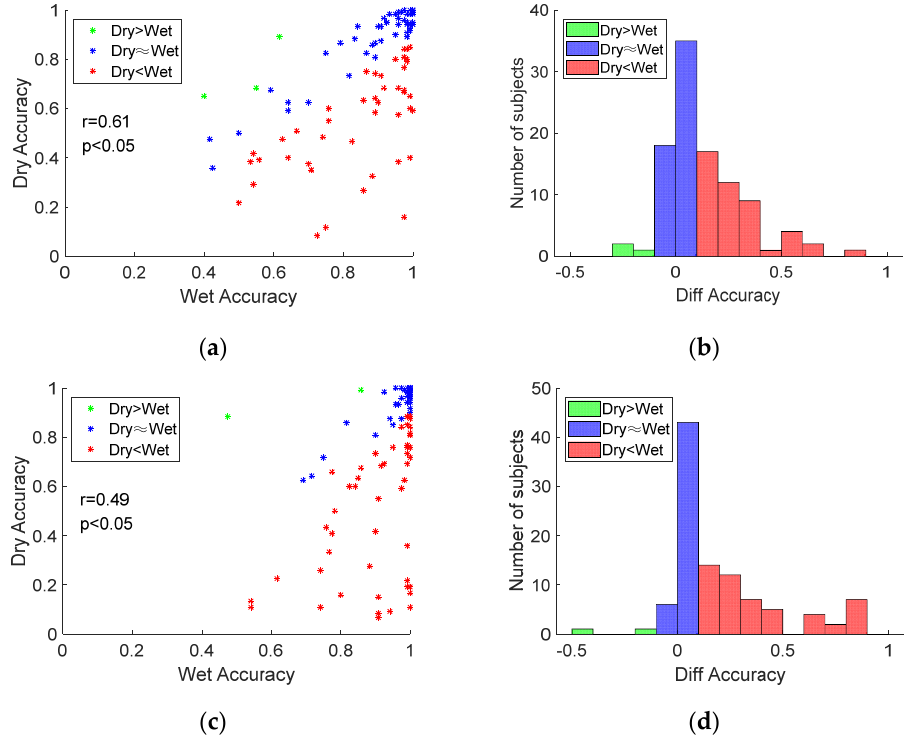
Figure 8. Correlation analysis of the performance between dry and wet electrodes for each subject: ( a ) FBCCA, ( c ) FBTRCA. Distribution of the number of subjects with regard to the accuracy difference between wet and dry electrodes: ( b ) FBCCA, ( d ) FBTRCA.